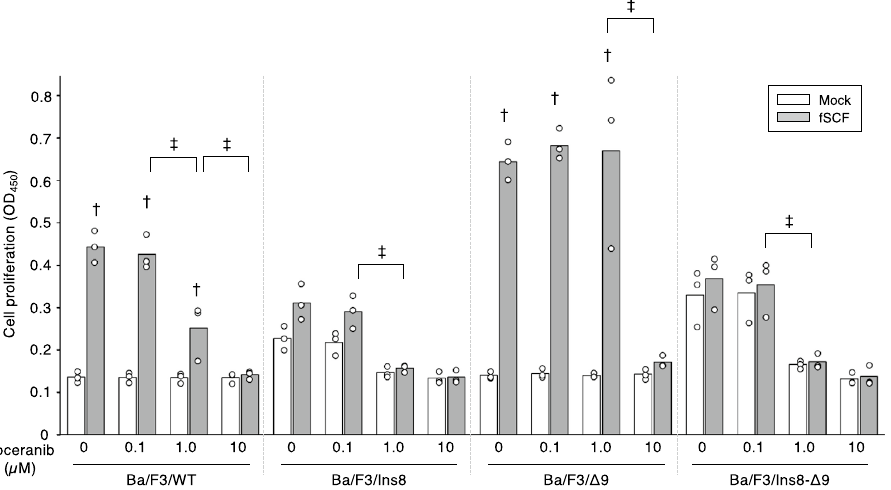
Figure 4. The effects of toceranib on cell proliferation rate of Ba/F3 cell lines expressing mutant c-KIT proteins. Cell proliferation rate of Ba/F3 cell lines expressing each mutant c-KIT protein was examined with the different amounts of toceranib (0, 0.1, 1.0 and 10 µM). Each mutant cell line was cultured for 48 h in the medium (mock, white bar) or with fSCF (gray bar). After 48 h, CCK-8 was added, and the cell proliferation rate was measured by plate reader. Bar graph indicates the mean from three independent biological replicates, and open dots indicate the values obtained from each experiment. p -values were calculated for the comparison among all cell lines using two-tailed one-way ANOVA with a post hoc Tukey–Kramer test. Dagger indicates a significant difference ( p < 0.05) between with or without fSCF, within each cell line. Double dagger indicates the significance ( p < 0.05) between the different dosages within fSCF-treated each cell